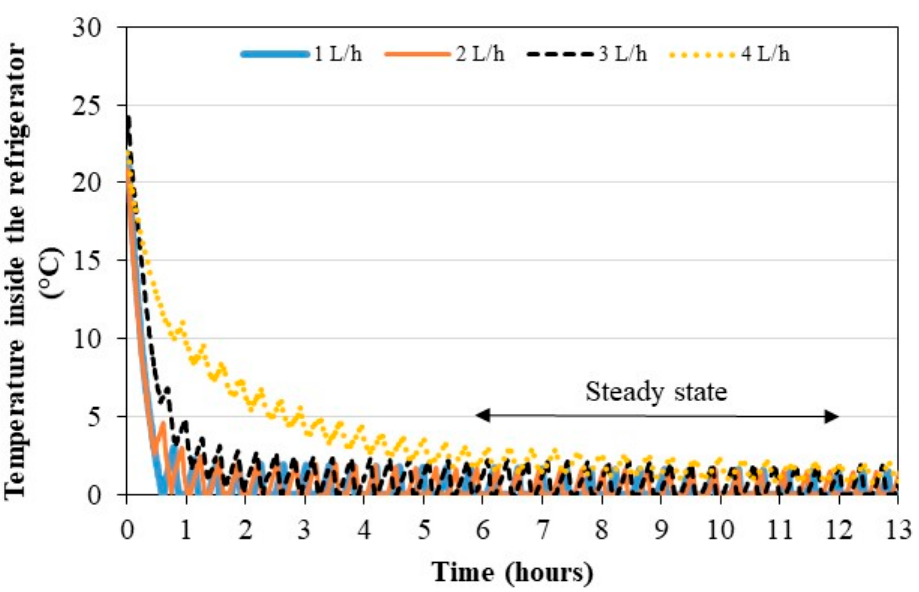
Figure 13. Dynamic behavior of the refrigerator air temperatures for different operating flow rates in controlled mode.